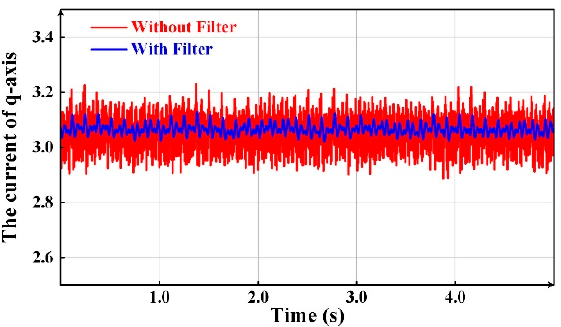
Figure 8. The q-axis current when m = 1 and n = 1 with or without filters.